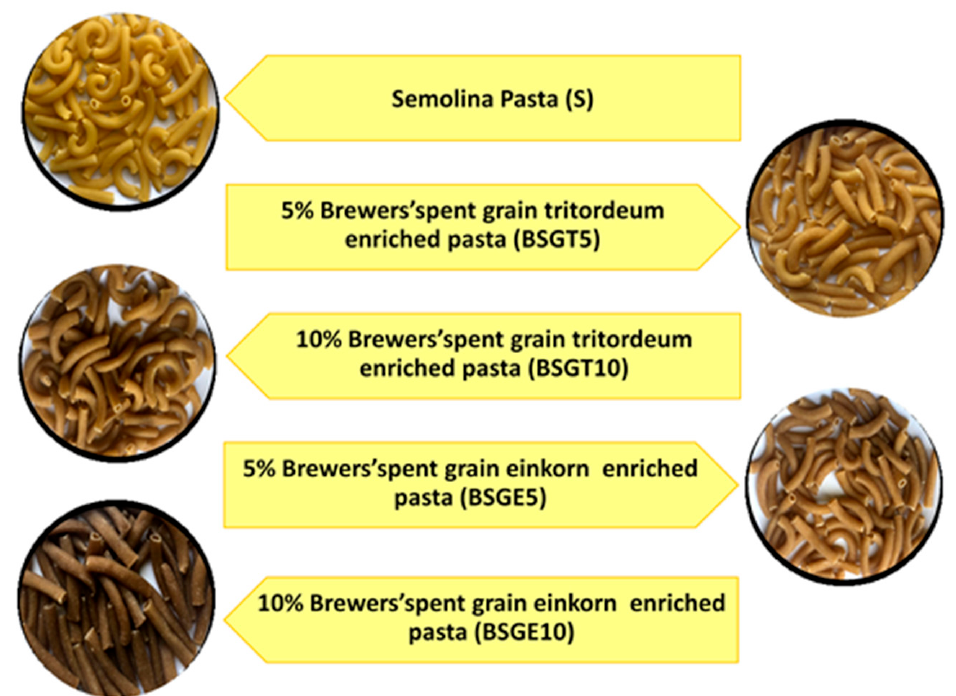
Figure 1. Dry pasta formulations: S = semolina 100%; BSGT5 = semolina:tritordeum Brewers’ spent grain (BSGT) 95:5 ( w : w ); BSGT10 = semolina:BSGT 90:10 ( w : w ); BSGE5 = semolina:einkorn BSG 95:5 ( w : w ); BSGE10 = semolina:BSGE 90:10 ( w : w ).